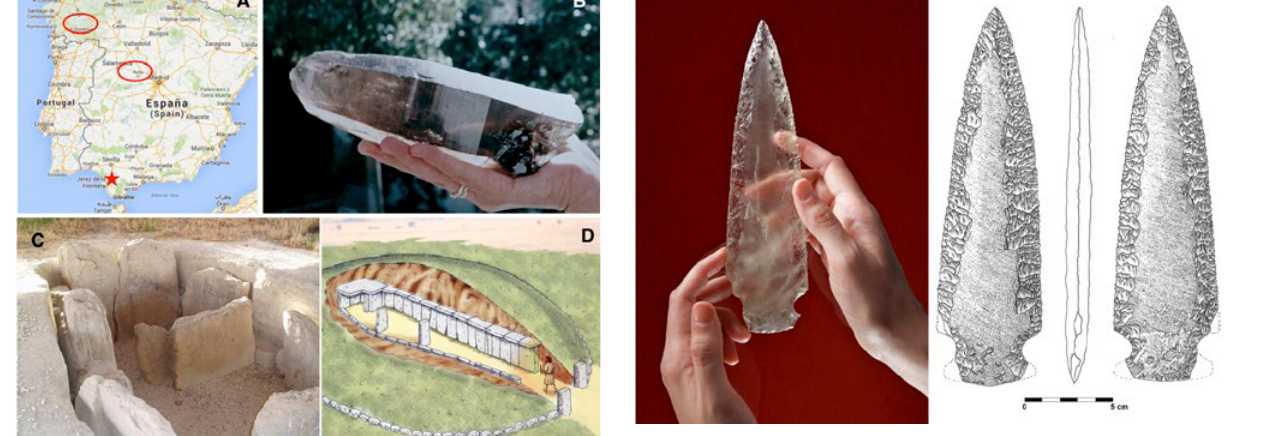
Figure 5. A 25 cm long dagger blade of rock crystal from the Cop- per Age found in tomb 10.042-10.049 of the Archaeological Zone of Valencina de la Concepción-Castilleja de Guzmán (Seville). Pho- tography: Miguel Ángel Blanco de la Rubia. Courtesy of the ATLAS Research Group (University of